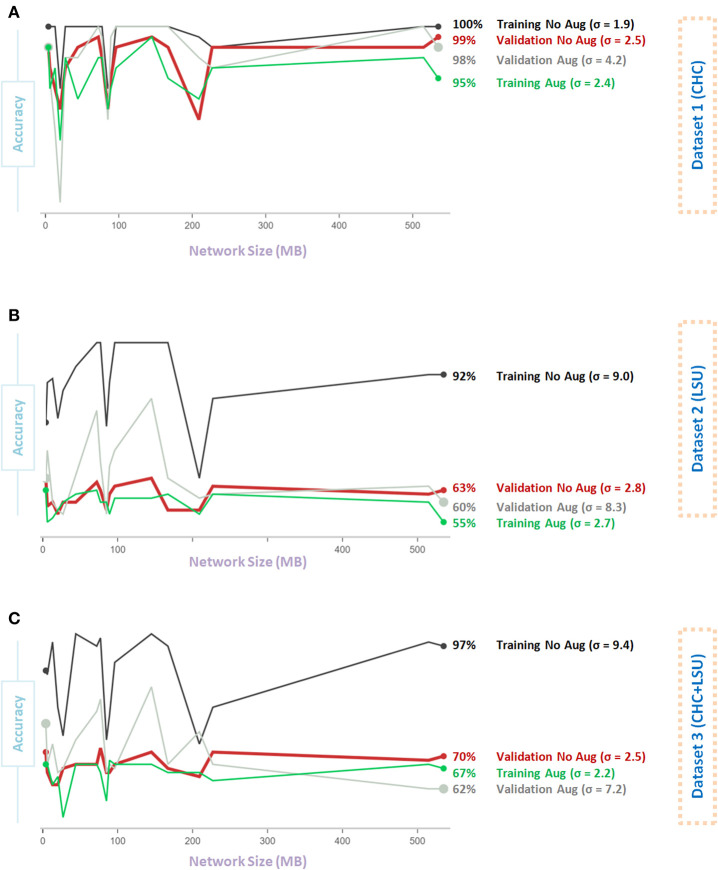
Effect of network size on Data Augmentation 4 (6) for detecting X-ray images with and without COVID-19. (A) CHC Dataset. (B) LSU Dataset. (C) CHC+LSU Dataset. Here, σ refers to standard deviation of performance with respect to network size, which is calculated to measure stability over different network sizes, high value means less stability.